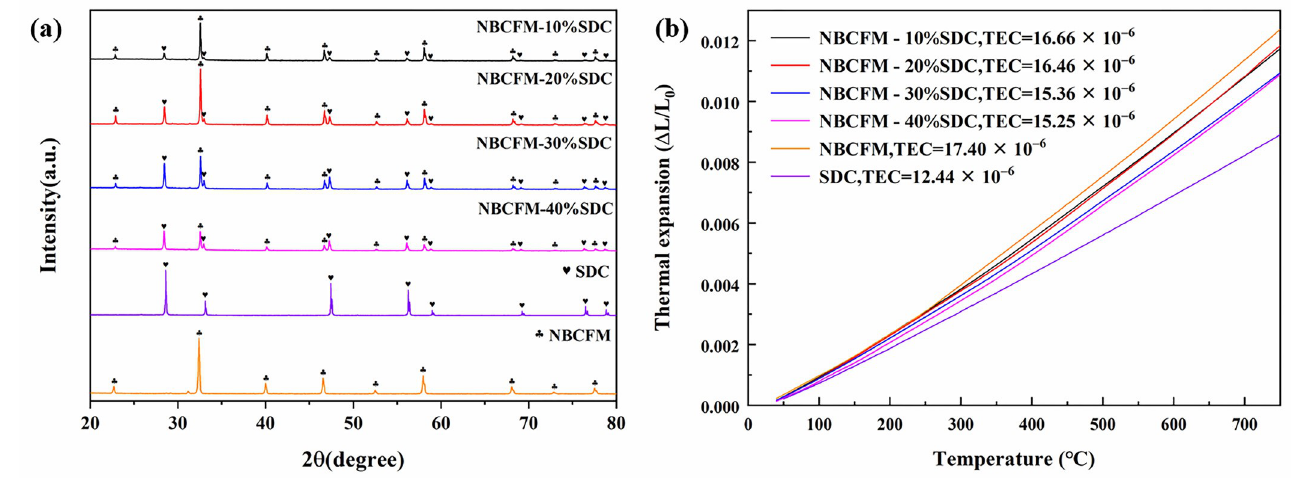
Figure 2. ( a ) The XRD profiles of the SDC, NBCFM, and NBCFM- x SDC powders after calcination at 1000 ◦ C; ( b ) thermal expansion curves of SDC, NBCFM, and composite